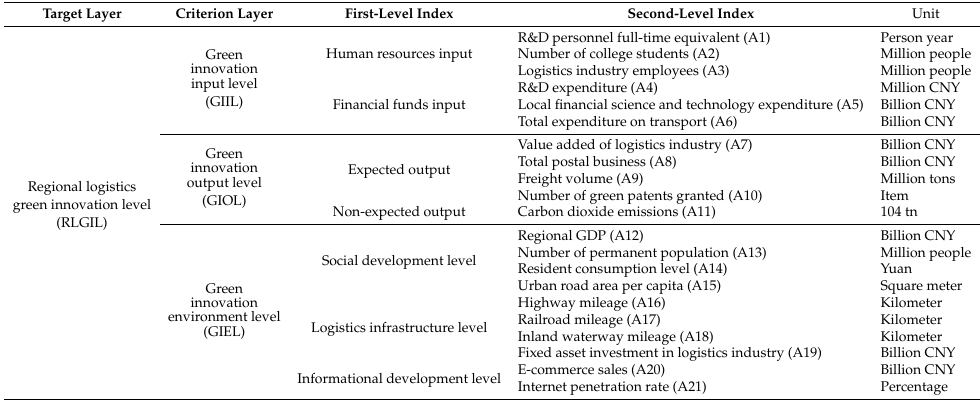
Table 2. Evaluation index system of regional logistics green innovation